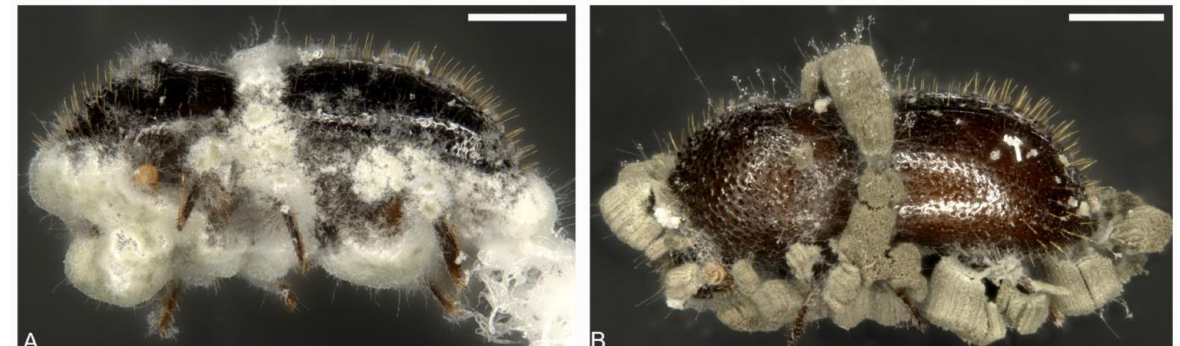
Figure 2. Mycosis observed in individual beetles from the direct application assay after continued incubation in moist chambers: ( A ) beetle inoculated with Eco-Bb ® showing Beauvaria bassiana growth, and ( B ) beetle inoculated with Bio-Insek showing Metarhizium anisopliae growth. Scale = 0.5